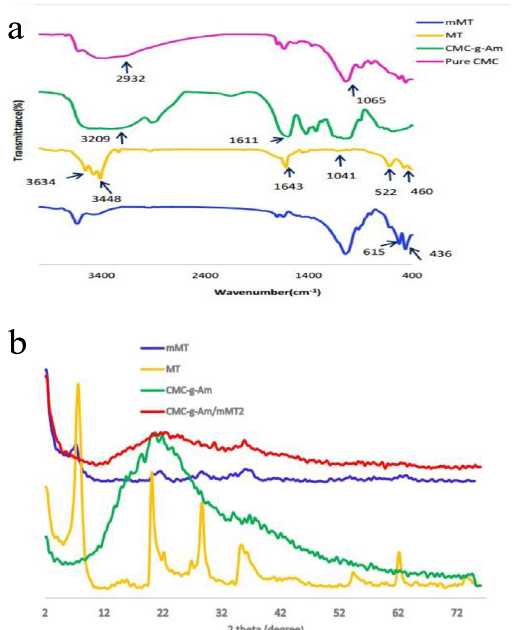
Fig. 1. (a) FT-IR Spectrum of pure CMC, CMC-g-Am, MT and mMT. (b) XRD patterns of pure MT, mMT, CMC-g-Am,